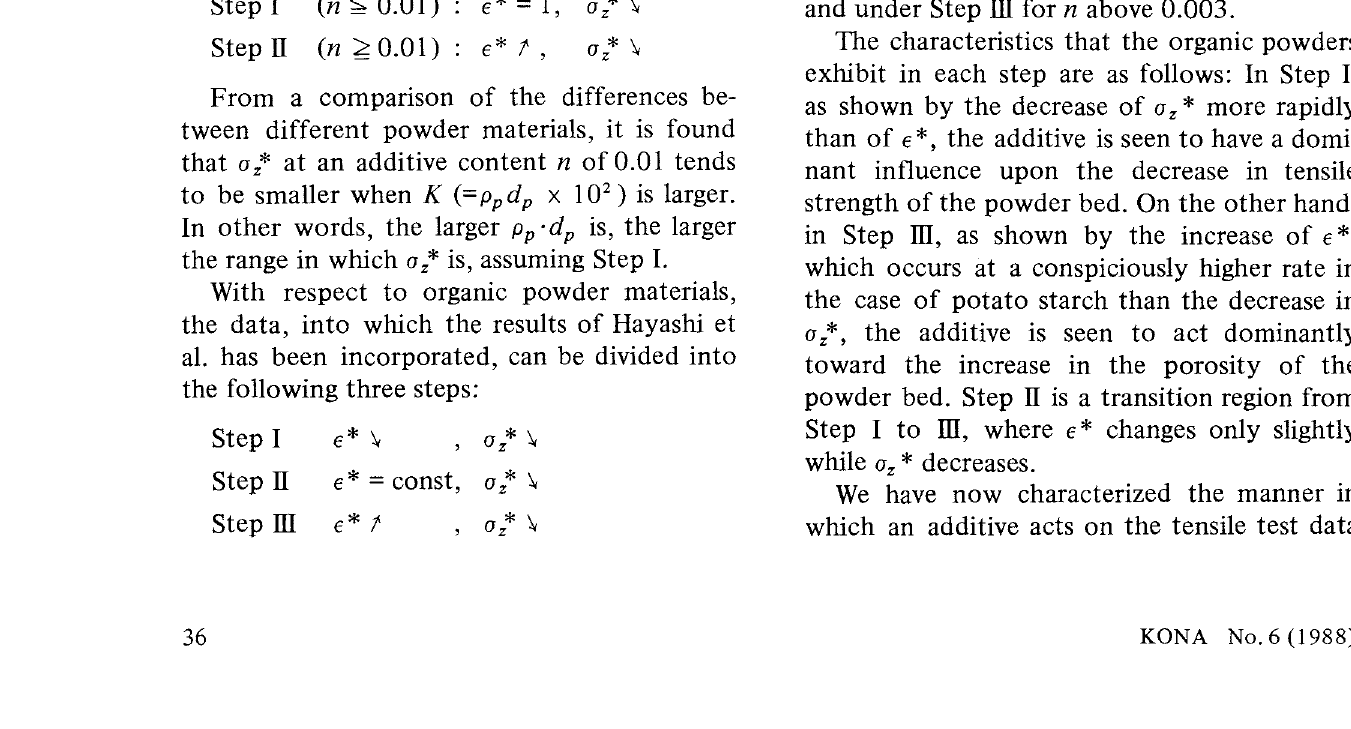
Fig. 1 1 Effect of pre-compressive stress on relationship between az* and E*